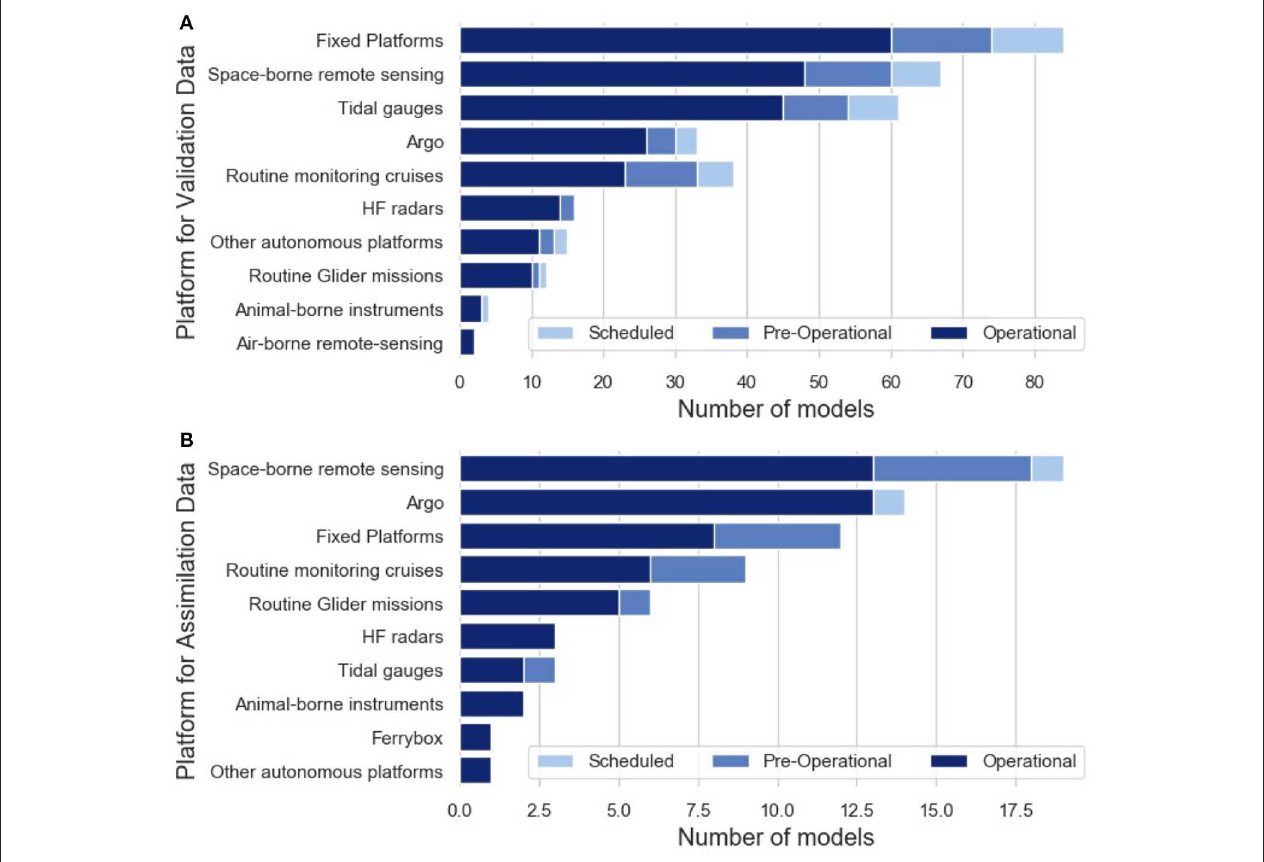
FIGURE 11 | Observing platforms providing data used for (A) model skill assessment and validation purposes, and (B) assimilation in the operational modeling